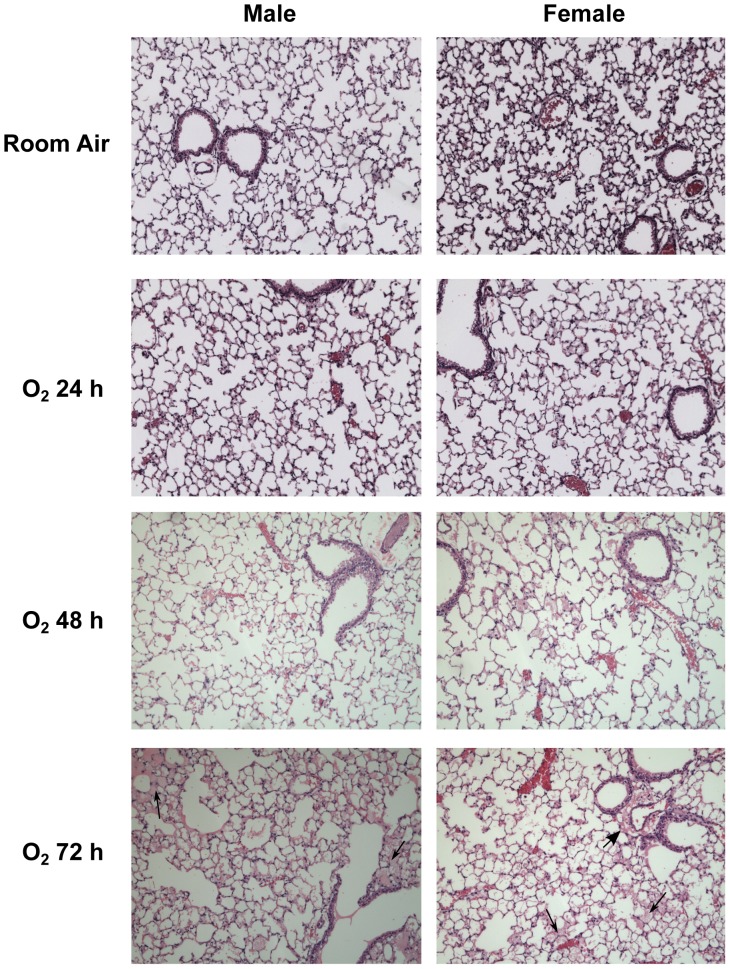
Representative hematoxylin eosin stained images from the lungs of male and female mice (n = 5 mice per group) exposed to room air or 24–72 h of hyperoxia.WT males show more alveolar edema and hemorrhage when compared to female mice. Thin arrows point to areas of alveolar edema. Thick arrow points to area of perivascular edema.